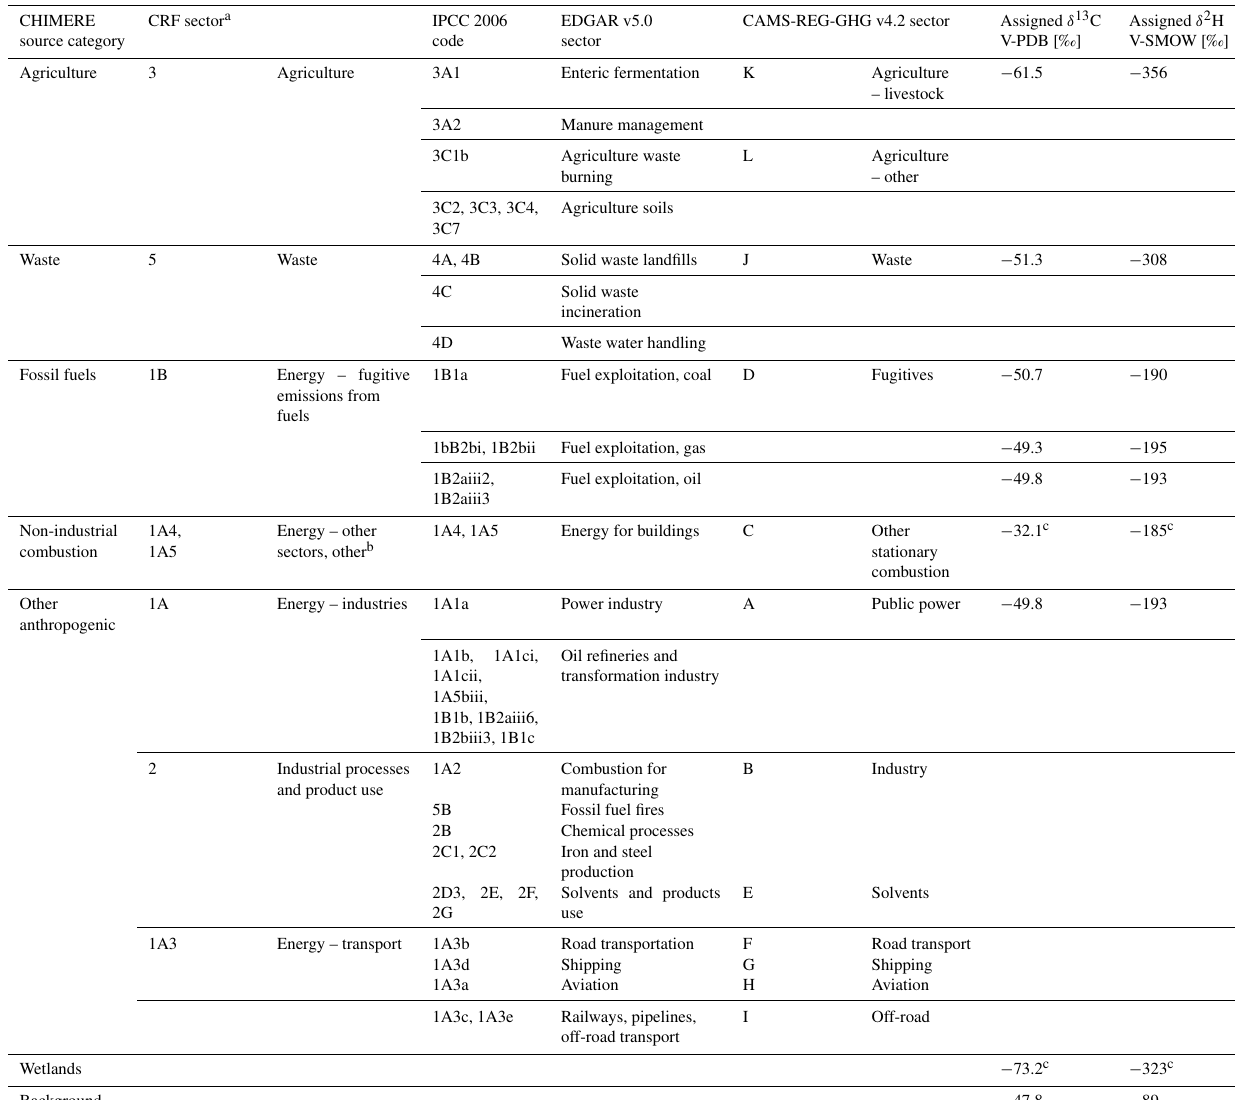
Table 1. Methane emission categories considered for this study, with the corresponding classification in the inventories, and the respective isotopic signature used to compute δ 13 C and δ 2 H time series with CHIMERE. If no references are specified, the assigned isotope values are derived from the sampling campaigns we carried out in the study area and described in this